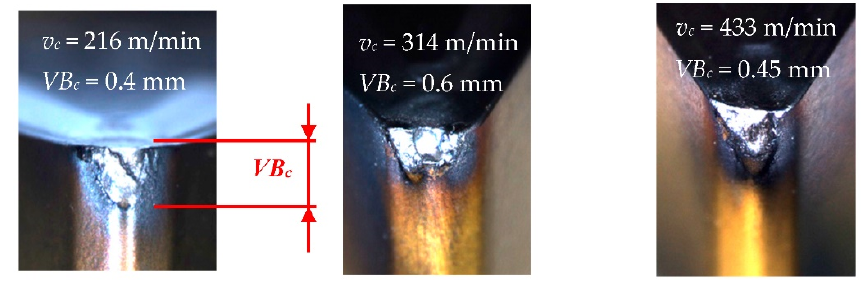
Figure 2 . Tool corner wear VB C after turning with various cutting speed. Figure 2. Tool corner wear VB C after turning with various cutting speed.